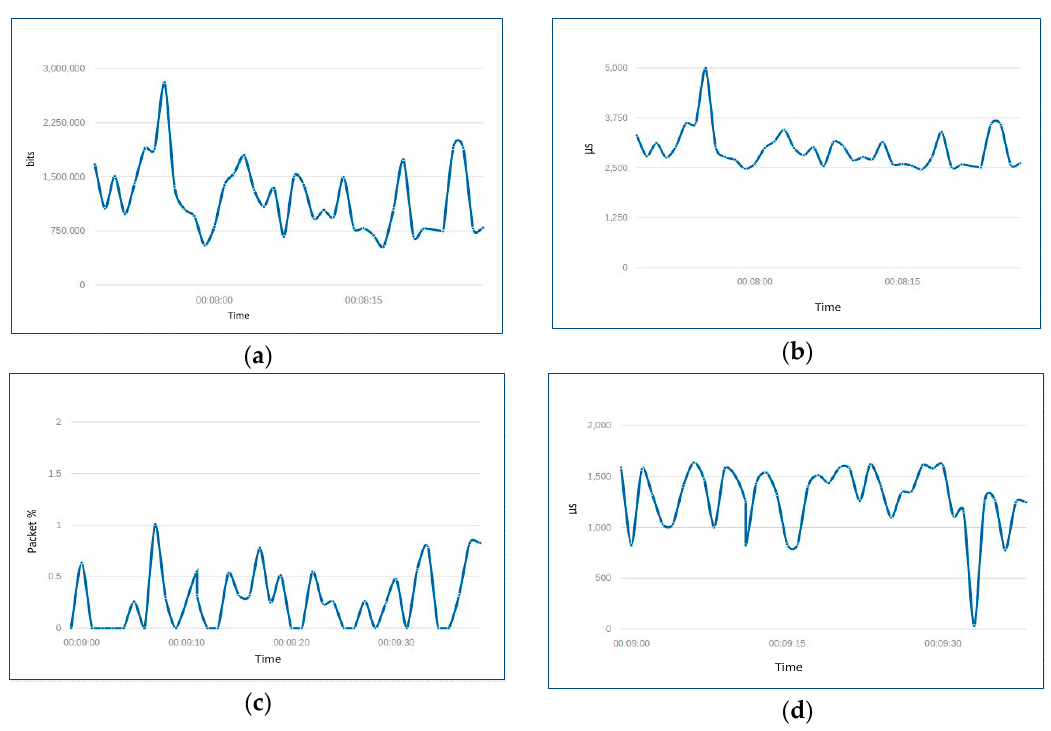
Figure 10. QoS monitoring over LLDP Frontend GUI at the controller A. ( a ) B.S4-eth2: Bandwidth; ( b ) B.S4-eth2: Delay; ( c ) B.S4-eth2: Jitter; ( d ) B.S4-eth2: Packet loss. Table 2. (QoS monitoring vs. topology discovery) over